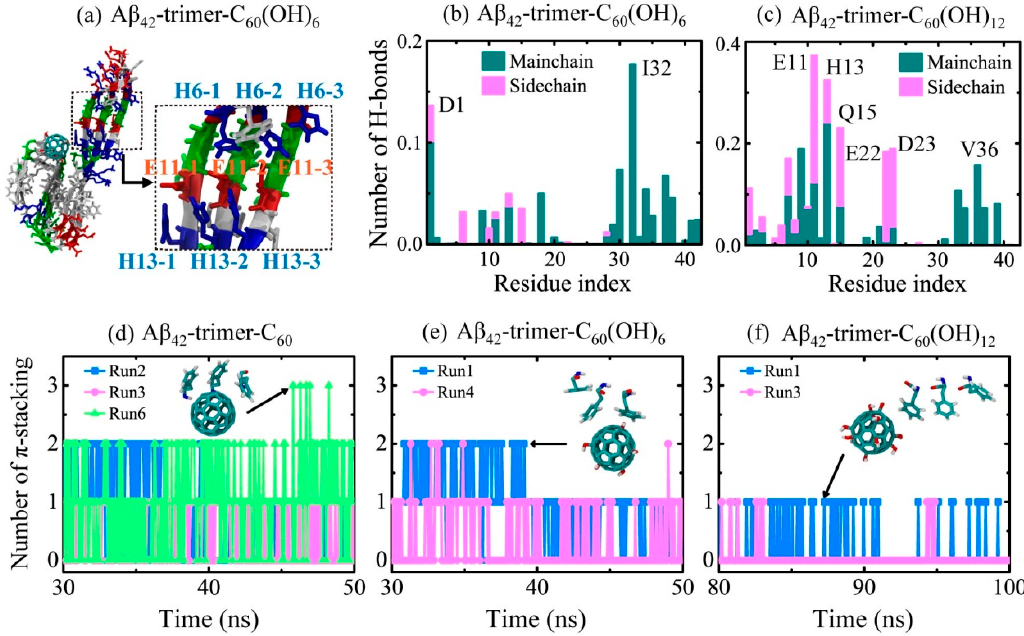
Figure 5. Details of interactions between A β 42 -trimer and the fullerene/fullerenol molecule. ( a ) Disturbance to the interplay of H6-E11-H13 observed in a trajectory of A β 42 -trimer-C 60 (OH) 6 system. ( b , c ) Number of H-bonds formed between A β 42 -trimer and fullerenols. ( d – f ) Number of π -stacking structures between A β 42 -trimer and fullerene/fullerenol. The geometrical criterions of H-bonding and π -stacking formations are defined in Model and Methods section.